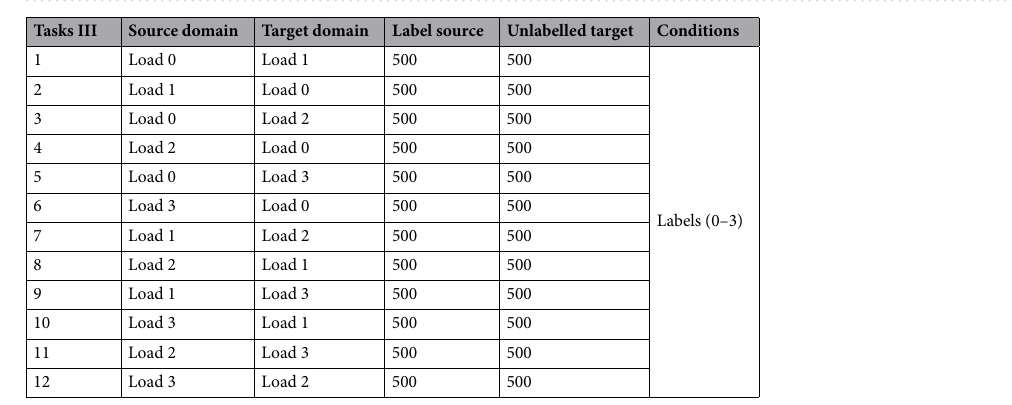
Figure 5. The comparative experimental results (task II). ( a ) Specificity (%); ( b ) precision (%); ( c ) recall (%); and ( d ) F (%).